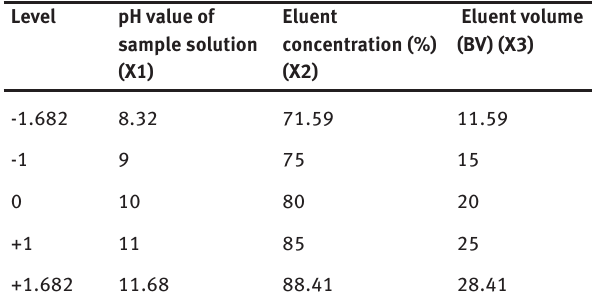
Figure 5: Desorption rate at different flow velocities.